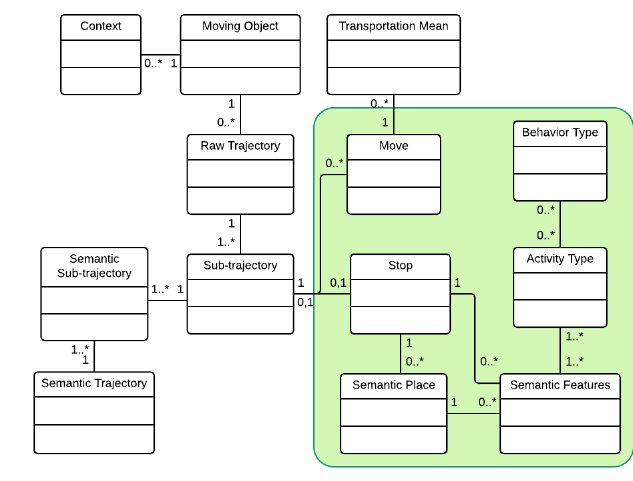
Figure 2. Extended conceptual model of semantic trajectory used in this